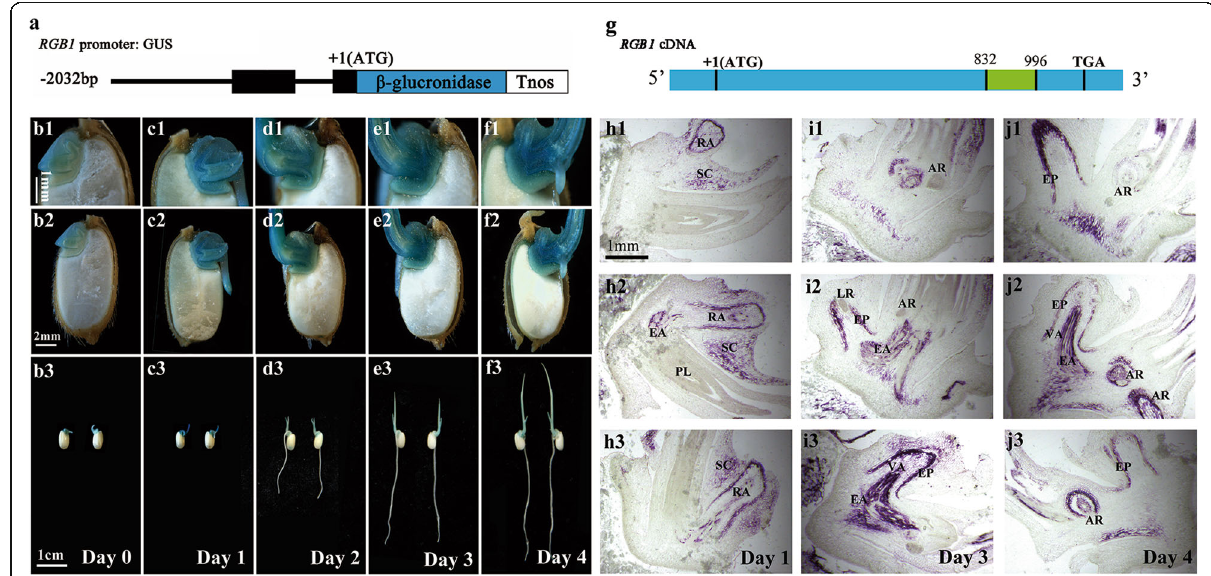
Fig. 2 Expression pattern analysis of RGB1 in the embryo during early postgermination development in rice. (a) RGB1 promoter::GUS fusion gene. The 2.032-kb promoter region and the 105-bp fragment after ATG of RGB1 were used to drive the expression of the GUS gene. (b-f) Expression of the RGB1:GUS construct in median longitudinal sections of embryos. RGB1 was expressed in geminated seeds and young seedlings, strongly in the shoot-root axis. (b1-b3) Germinated seeds, (c1-c3) 1-day-old seedlings, (d1-d3) 2-day-old seedlings, (e1-e3) 3-day-old seedlings, (f1-f3) 4- day-old seedlings. (g) Location of the probe used for in situ hybridization of the RGB1 cDNA sequence (the fragment is shown in green). (h-j) In situ hybridization detection of RGB1 transcripts in rice embryos after germination. (h1-h3) Median longitudinal sections of 1-day-old wild-type seedlings. RA, radicle. SC, scutellum. EA, embryonic axis. PL, plumule. (i1-i3) Median longitudinal sections of 3-day-old wild-type seedlings. AR, adventitious root. EP, epidermis. EA, embryonic axis. VA, vascular tissue. LR, lateral root. (j1-j3) Median longitudinal sections of 4-day-old wild-type seedlings. AR, adventitious root. EP, epidermis. EA, embryonic axis. VA, vascular tissue. LR, lateral